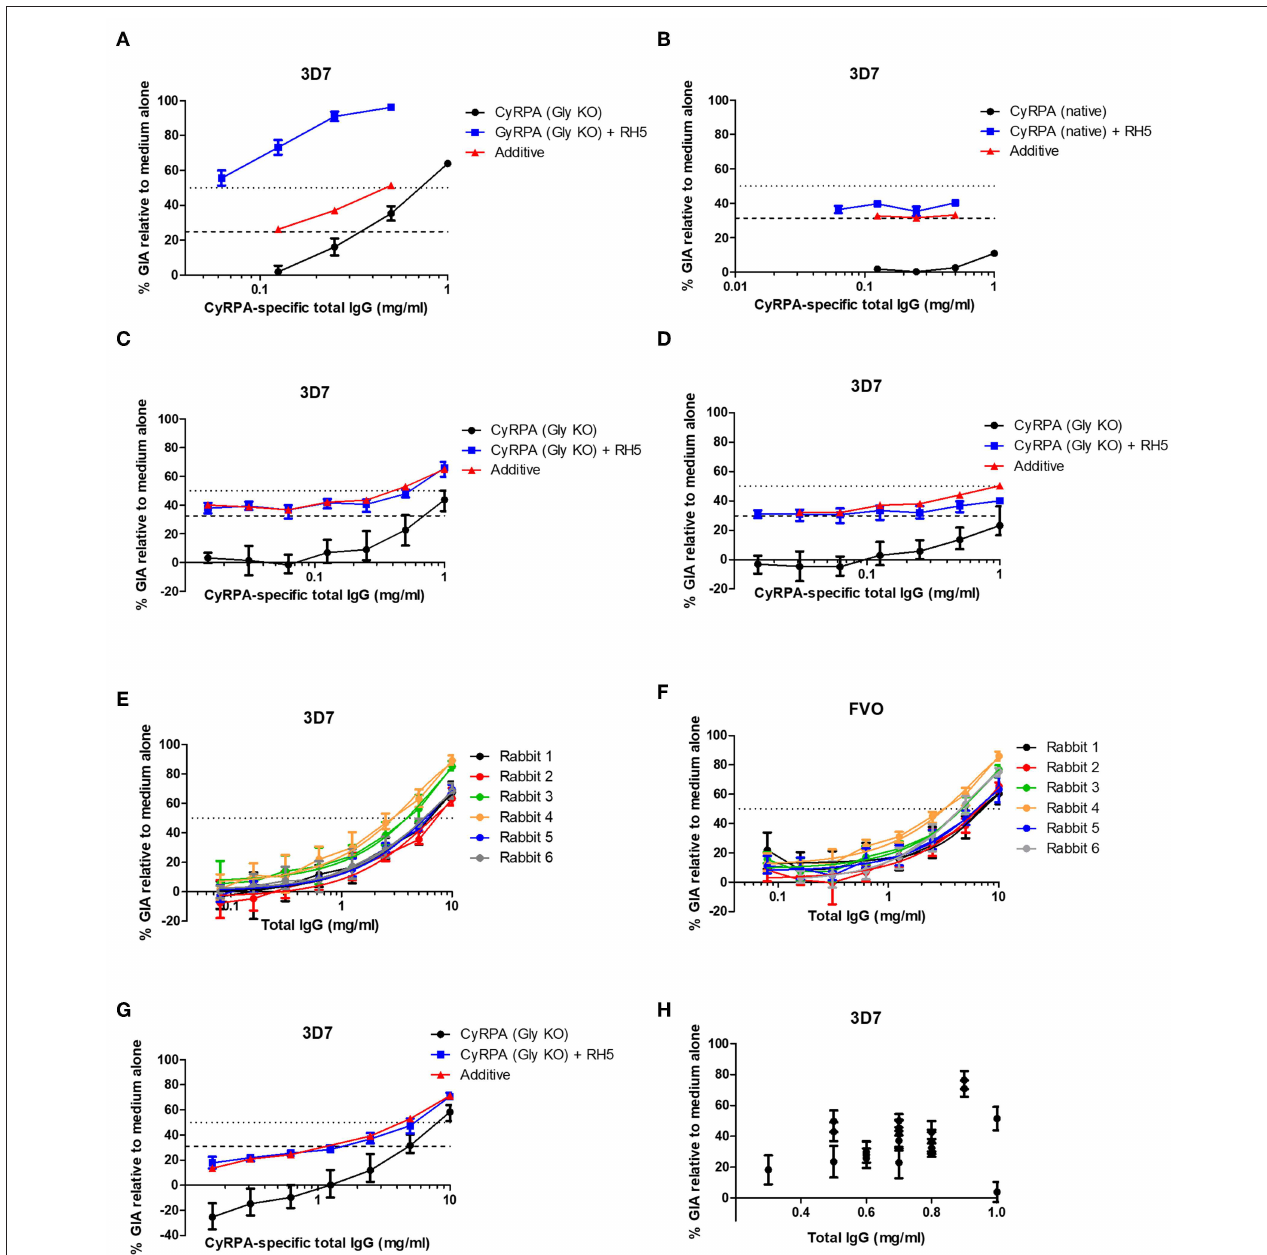
FIGURE 5 | Functional activity of anti-CyRPA antibodies in the in vitro assay of GIA. (A,B) Titration of the anti-CyRPA purified IgG samples (from Figure 3A ) against 3D7 clone parasites, with (blue line) and without (black line) addition of a fixed concentration (1.25 mg/mL) rabbit anti-RH5 purified IgG antibodies. Dashed line shows the activity of the anti-RH5 IgG alone tested at the single fixed concentration and red line shows the calculated activity of the mixture, assuming Bliss additivity (30). Dotted line indicates 50% GIA. (C) A new sample of mouse anti-CyRPA (GlyKO) IgG was generated and assessed as in (A) . (D) A new sample of mouse anti-CyRPA (Gly KO) IgG was generated using an identical immunogen to (A,C) , but using Poly(I:C) adjuvant for formulation. (E,F) Six rabbits were immunized with CyRPA (Gly KO) in AddaVax TM and their total IgG tested in a titration series for GIA against 3D7 clone and FVO strain parasites. (G) Pooled IgG antibodies from the six rabbits in panels (E,F) were tested for synergy against the 3D7 clone with anti-RH5 IgG antibodies as in (A,B) . (H) GIA of total IgG purified from 20 individual mice immunized with CyRPA (Gly KO) and AddaVax TM , each tested at a different concentration as defined by IgG yield in the sample. All panels show representative results from two replicate GIA assays, except (E) which was repeated 3 times. Each point shows the mean of three replicate wells; error bars show the range of three replicates wells.